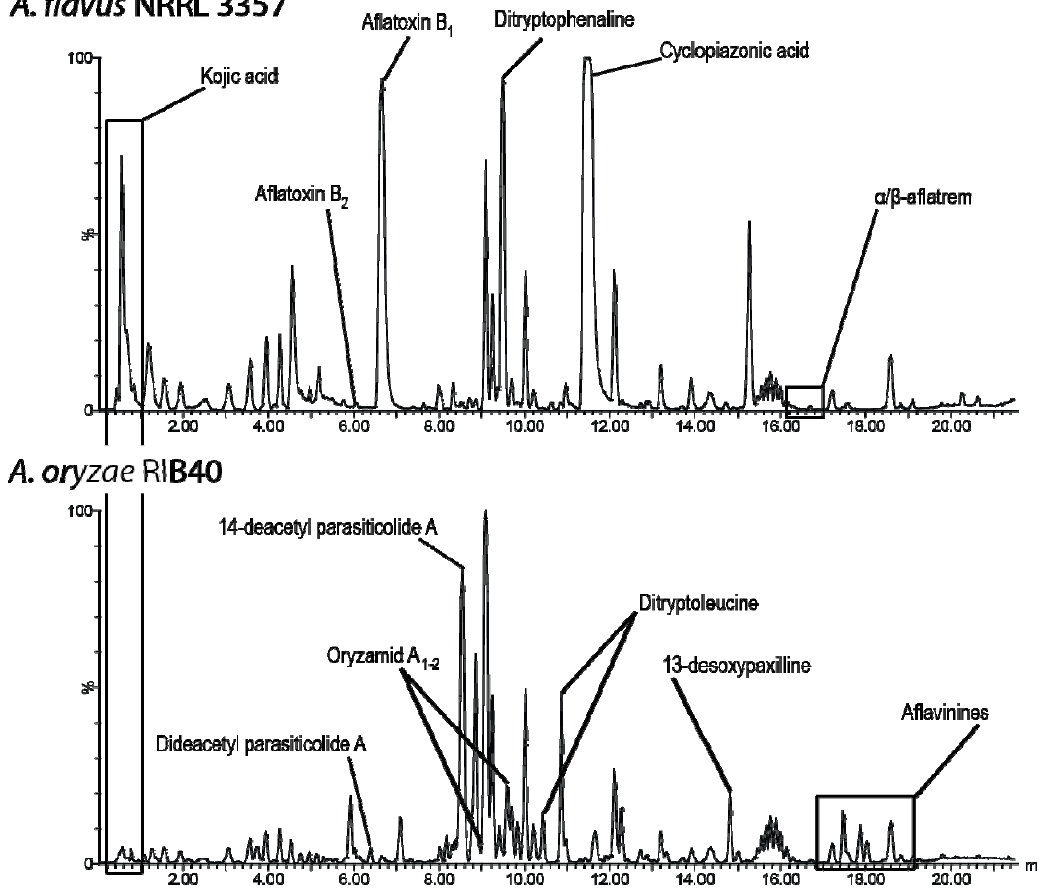
Figure 2. ESI+ BPC chromatogram of 7 day micro scale extract from WATM, bottom: A. oryzae RIB40, top: A. flavus NRRL 3357. Besides kojic acid (shown in box) and analogues in the beginning of chromatogram and ergosterol in the end (not shown), there are very few identical compounds between the genetically almost identical strains. Note that aspirochlorine is only detectable in negative ionization, and therefore not visible in this chromatogram.